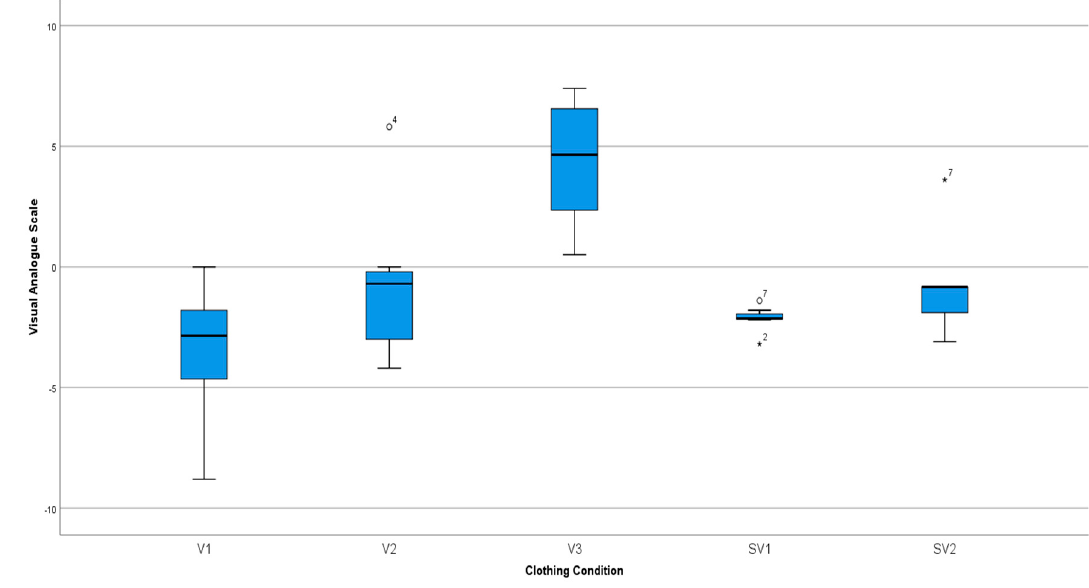
Figure 7. Subjective results of the FMS when compared to station wear.